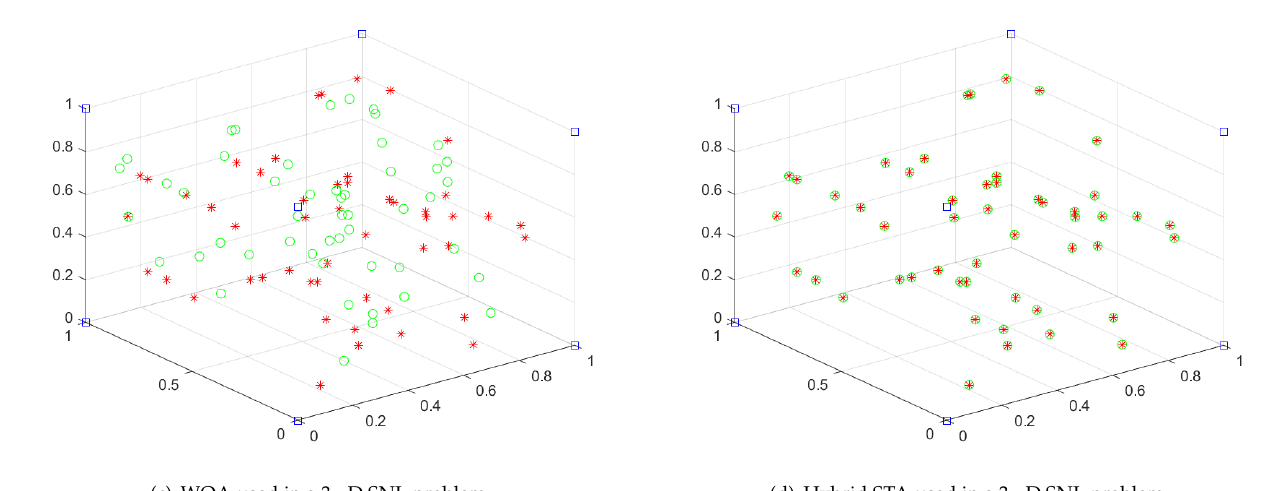
Figure 8. Optimization results of hybrid STA and WOA in 2 − D and 3 − D SNL problems. Figure 8a,b show the localization results of the WOA in two-dimensional and three- dimensional SNL problems. Figure 8c,d show the localization results of the hybrid STA in the two-dimensional and three-dimensional SNL problems. After using the hybrid STA, the estimation location almost coincided with the true location. However, after using the WOA, the estimation error remained large between the estimation location and the true location. In the SNL problem, the hybrid STA performed much better than WOA. Figure 9a,b show the convergent curves of the hybrid STA and other methods for the 2-D and 3-D SNL problems, respectively. Compared with other metaheuristic methods, the optimization accuracy and convergence speed of the hybrid STA were clearly better compared with the other algorithms.